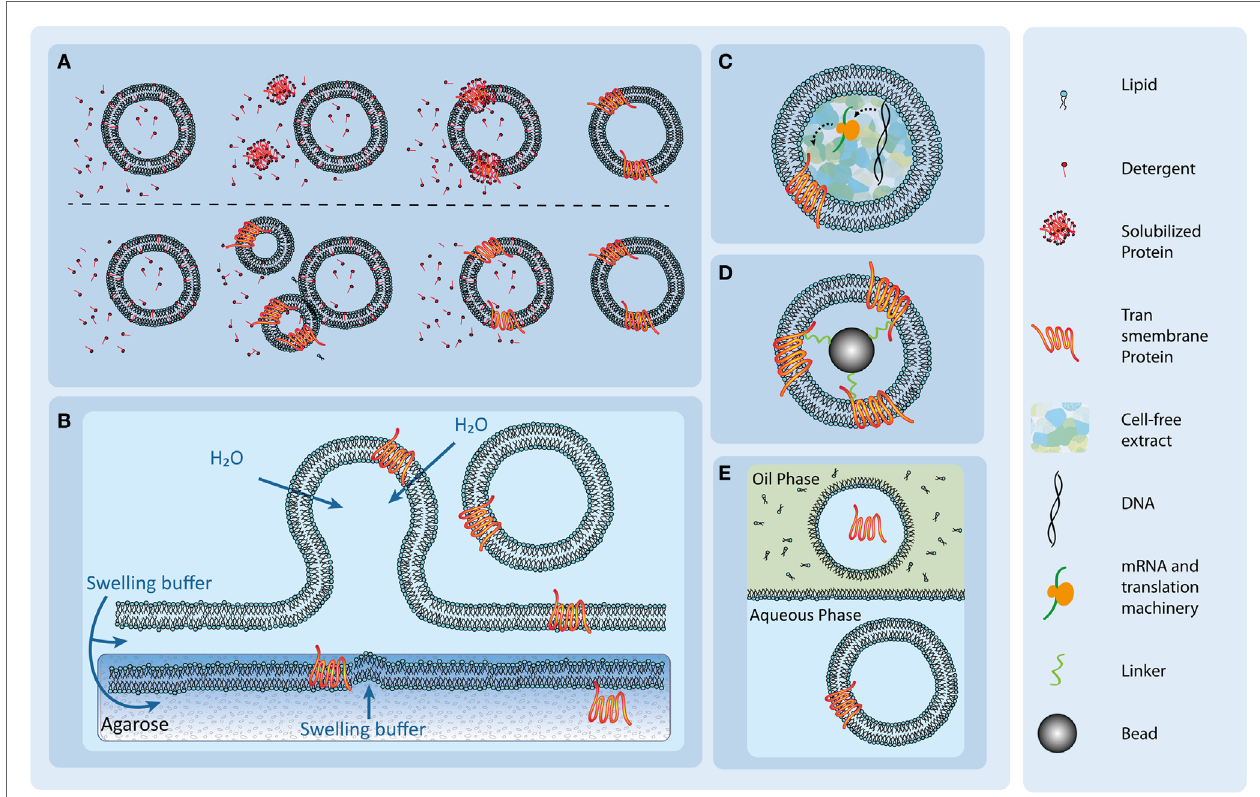
FiGURe 2 | Overview of different transmembrane protein reconstitution methods . (A) Detergent-mediated protein reconstitution uses detergent molecules to trigger reconstitution (upper row) and fusion events (lower row). After successful reconstitution, the detergent molecules are removed to form stable protein- containing vesicles. Illustration adapted from Dezi et al. (2013). (B) Protein reconstitution via spontaneous swelling of vesicles from a protein-containing agarose film. The solubilized proteins are added to the agarose gels and incorporate spontaneously upon lipid addition and swelling. (C) An internalized cell-free extract supplied with specific DNA of the transmembrane protein leads to reconstitution of the protein in the vesicle membrane. Illustration adapted from Kaneda et al. (2009). (D) A proteoliposome is formed with the use of antibody or protein ligand-coated beads and the subsequent addition of lipids. Illustration adapted from Frank et al. (2015). (e) Spontaneous protein insertion in a double-emulsion setup. A lipid monolayer forms on the border between a lipid containing oil phase and an aqueous phase. Upon addition of an aqueous droplet, containing the solubilized protein, a micelle forms around the droplet, enclosing the solution. When the micelle passes through the lipid monolayer into the aqueous phase, a vesicle forms. The solubilized protein spontaneously inserts. Illustration adapted from Yanagisawa et al.